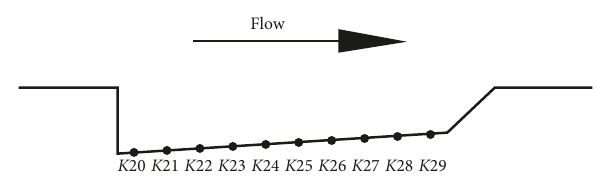
Figure 3: Monitoring points at the bottom of the deformable cavity. Table 1: Positions of monitoring